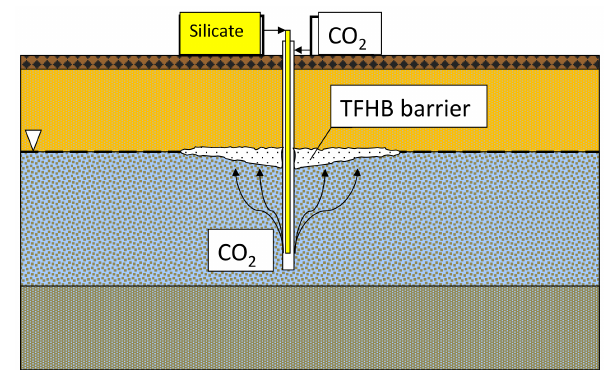
Figure 1. Creating a TFHB barrier in the roof of an aquifer.